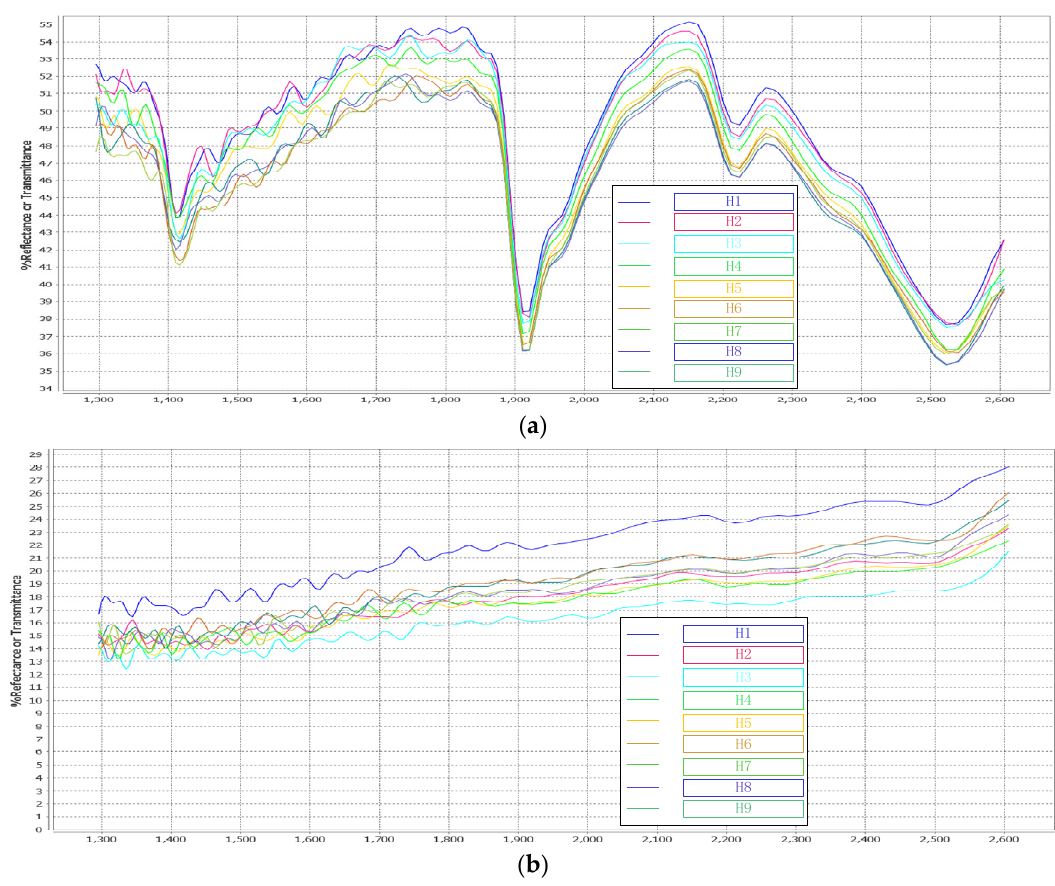
Figure 5. Near-infrared reflectance spectra of coal and gangue samples under different detection distances and dust concentrations. ( a ) Near-infrared reflection spectral curve of gangue, ( b ) Near- infrared reflection spectral curve of coal.